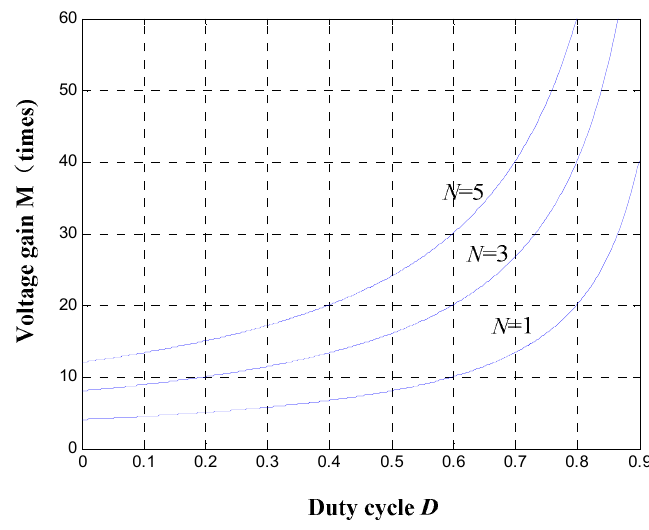
Figure 5. Relation curves of voltage gain with turns ratio and duty cycle.